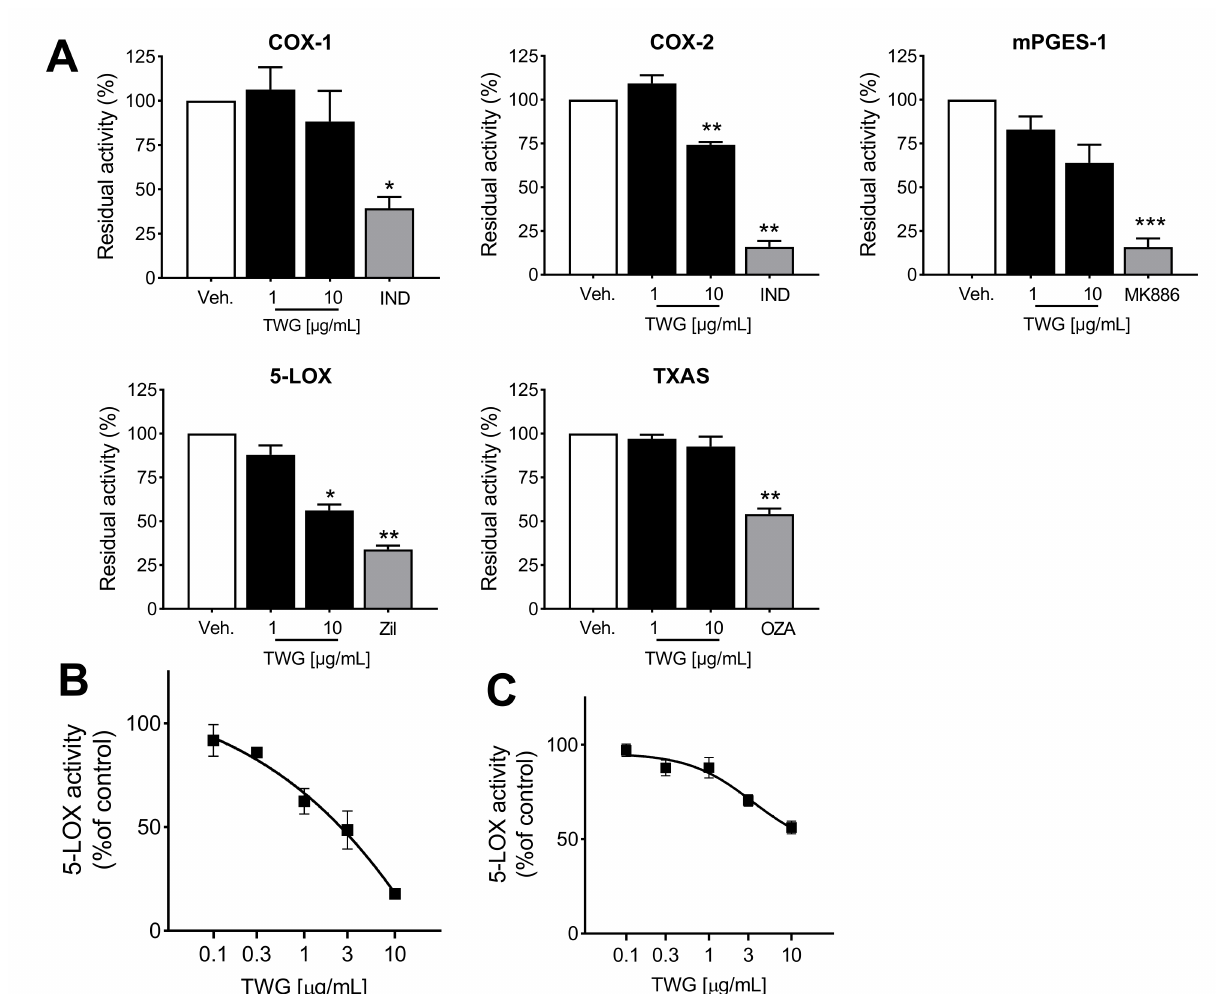
Figure 2. TWG selectively inhibits 5-LOX. ( A ) Effect of 1 and 10 µ g/mL TWG on the residual activities of isolated ovine COX-1, human recombinant COX-2 and 5-LOX, mPGES-1 in microsomes from A549 cells, and TXAS in homogenates of human platelets. Data are expressed as percentage of vehicle (=100%) and given as means ± S.E.M., n = 3 (for COX-1/2, 5-LOX) or n = 4 (for mPGES1, TXAs). Indomethacin (IND) 10 µ M, MK886 10 µ M, and zileuton 3 µ M were used as positive controls. * p < 0.05, ** p < 0.01, *** p < 0.001, TWG vs. control group, one-way ANOVA and Dunnett’s multiple comparisons test. ( B , C ) Concentration response curves of TWG for inhibition of ( B ) isolated human recombinant 5-LOX incubated with 20 µ M AA, and ( C ) 5-LO in human intact PMNL stimulated with 2.5 µ M A23187 plus 20 µ M AA. Data are means + S.E.M., n =